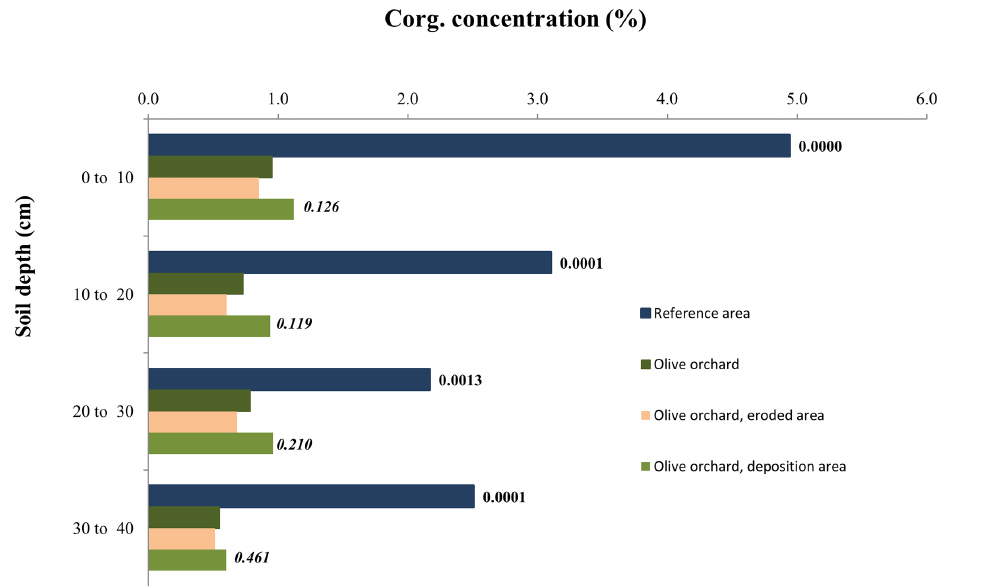
Figure 2. Comparison of average soil organic carbon concentration in bulk soil depending on soil depth, distinguishing between the reference site, the whole olive orchard, the eroded area of the olive orchard, and the deposition area in this orchard. The labels of the bars for each depth indicate the p value according to a one-way ANOVA for the reference area (dark blue) vs. the whole olive orchard (dark green) and for the eroding area (beige) vs. the deposition area (light green, lower label, in italics).